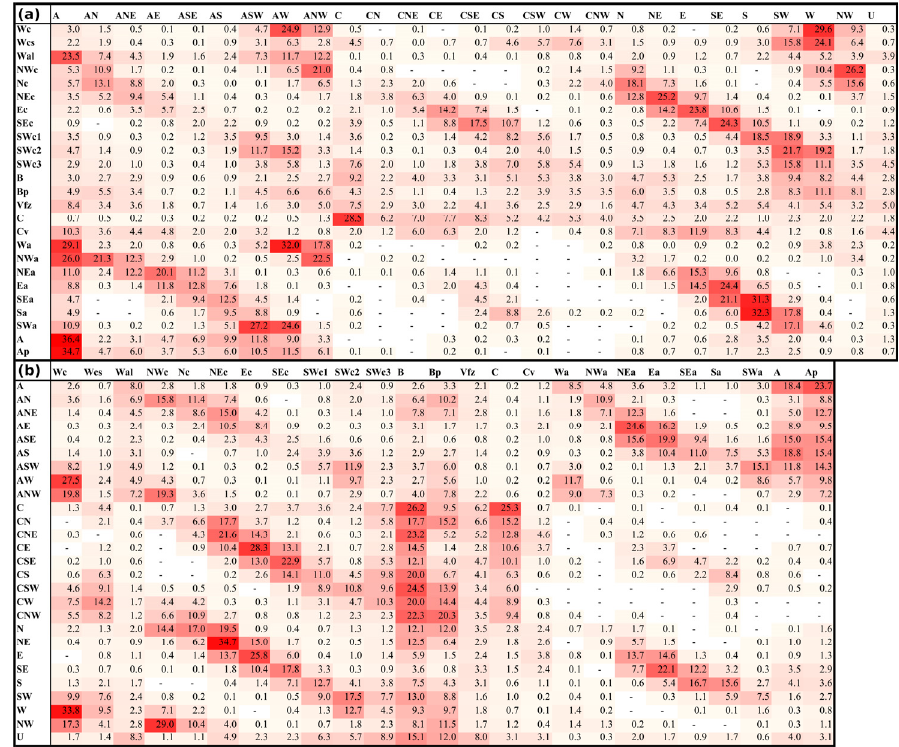
Figure 13. Relative occurrence frequencies of the individual circulation types under the objective classification to the occurrence frequencies of the individual types under the CHMI classification ( a ) and vice versa ( b ) during the 1961–2020 period. The values are highlighted by the color scale of red shades.